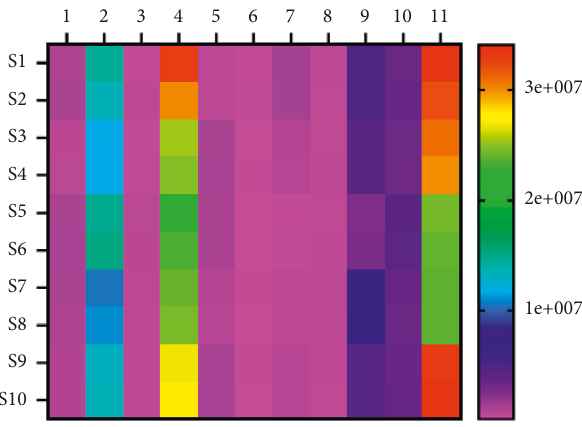
Figure 5: The heat map analysis of ten batches of Berberidis Cortex.